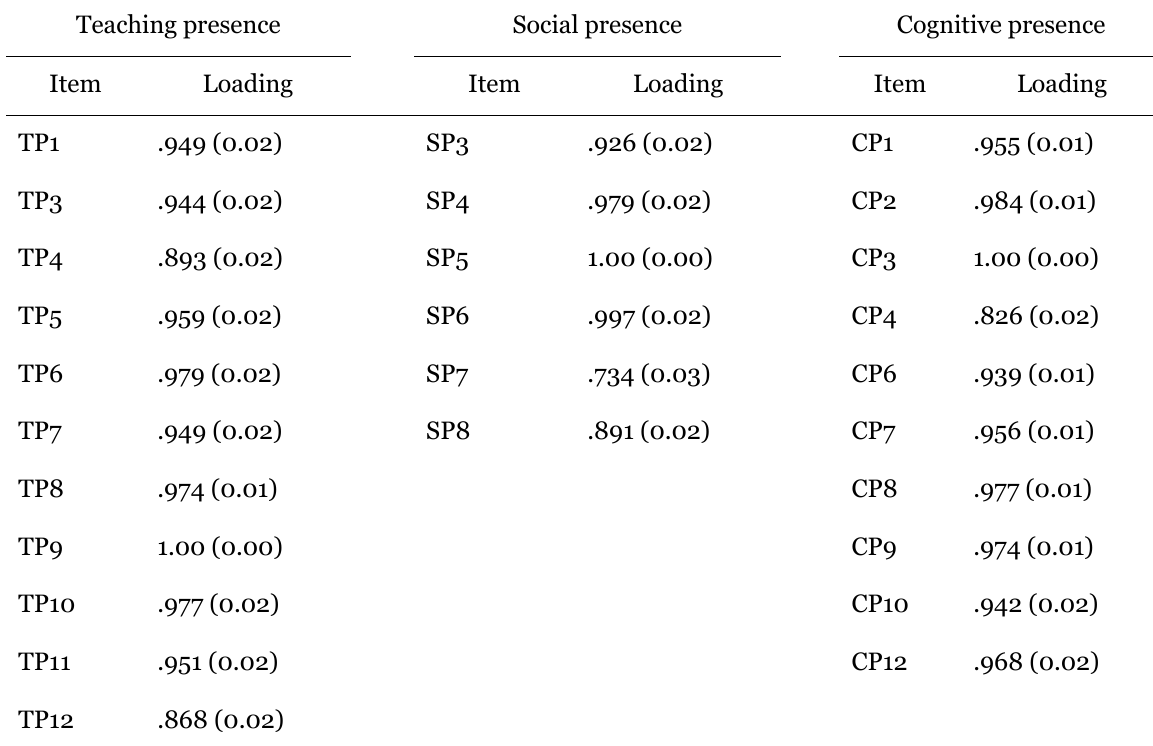
Factor Loadings for the Three-Factor Confirmatory Factor Analysis Teaching presence Social presence Cognitive presence Item Loading